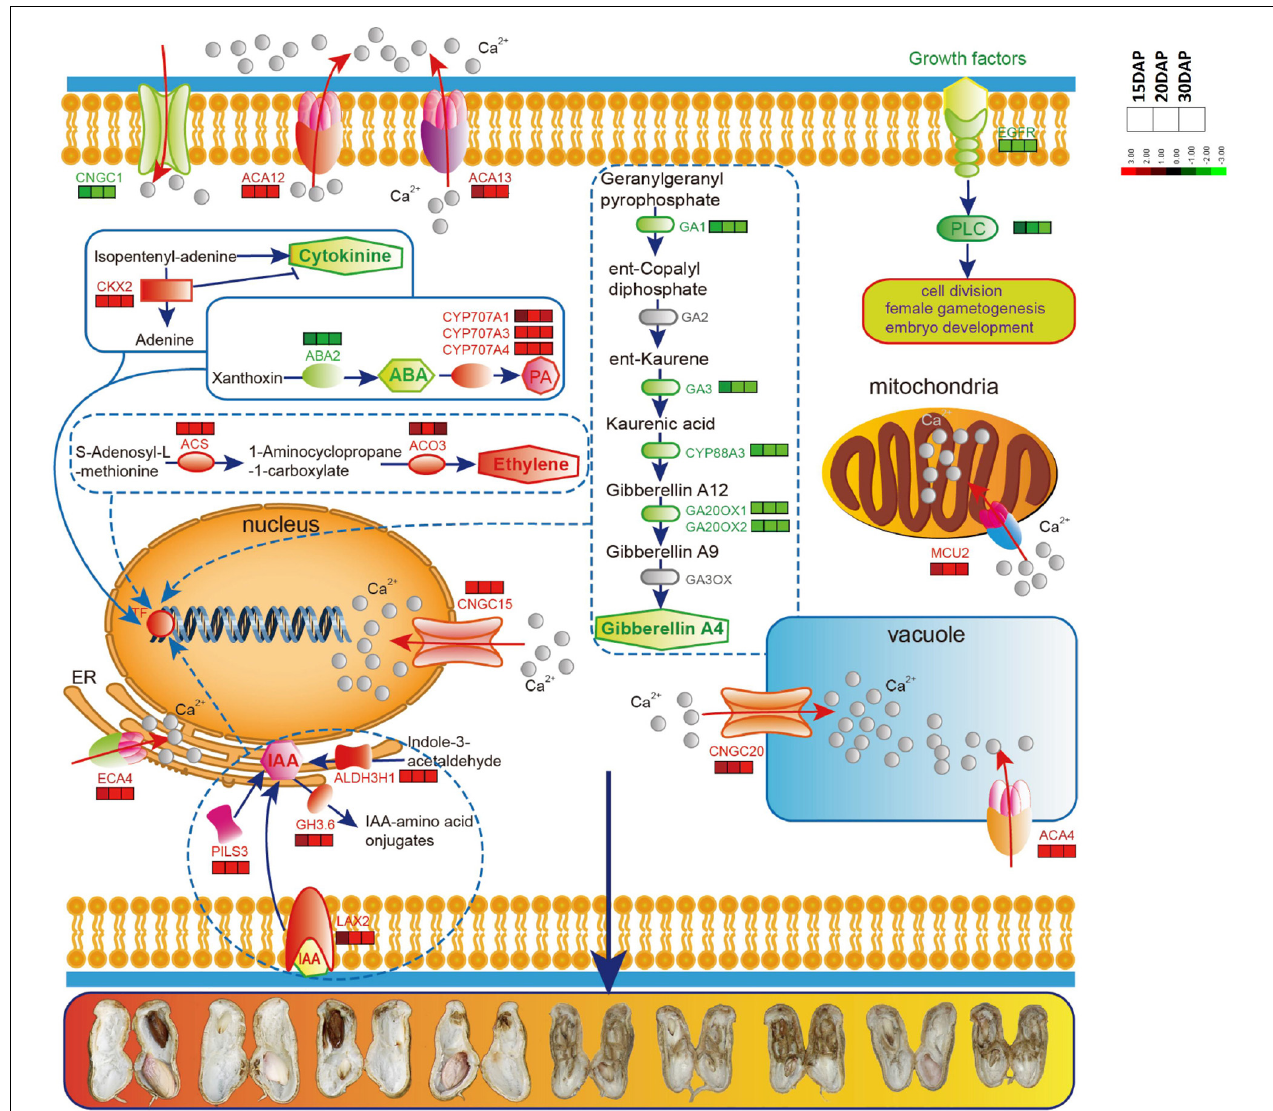
FIGURE 5 | The predicted schematic diagram of calcium signaling pathway and hormone biosynthesis related genes in peanut embryo cells and their subcellular localization. Red color indicates up-regulated genes, green indicates down-regulated genes. Calcium-transporting ATPases and Cyclic nucleotide-gated ion channels (CNGC) are localized in different intracellular organelles and have high capacity Ca 2 + flow across membranes. ACA12 and ACA13 are present in the plasma membrane, ACA4 in the vacuole and ECA4 in endoplasmic reticulum (ER). CNGC1 is in the plasma membrane, CNGC15 in nucleus and CNGC20 in vacuole membrane. EGFR, epidermal growth factor receptor; PLC, phosphoinositide phospholipase C; MCU2, calcium uniporter protein 2, mitochondrial; GA1, Ent-copalyl diphosphate synthase; GA3, Ent-kaurene oxidase; GA20OX1, Gibberellin 20 oxidase 1; GA20OX2, Gibberellin 20 oxidase 2; CKX2, Cytokinin dehydrogenase 2; ABA2, Xanthoxin dehydrogenase; CYP707A1, Abscisic acid 8 (cid:48) -hydroxylase 1; CYP707A3, Abscisic acid 8 (cid:48) -hydroxylase3; CYP707A4, Abscisic acid 8 (cid:48) -hydroxylase 4, ACS, 1-aminocyclopropane-1-carboxylate synthase; ACO3, PILS3, protein PIN-LIKES 3; GH3.6, Indole-3-acetic acid-amido synthetase GH3.6; ALDH3H1, Aldehyde dehydrogenase family 3 member